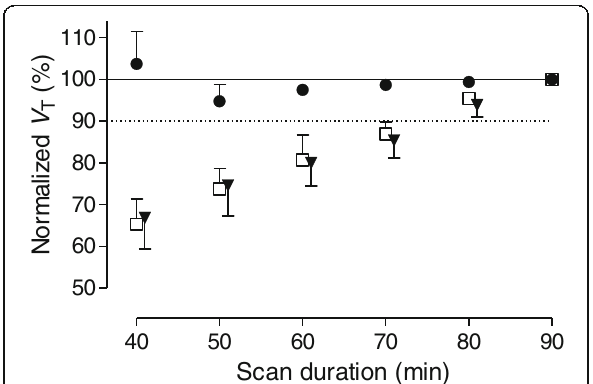
Fig. 1 Time-stability analysis. Total distribution volume ( V T ) of 11 C-( R) -PK11195 ( □ ), DPA-713 ( ▼ ), and ER176 ( ● ) obtained from low affinity binders (LABs) plotted as a function of duration of image acquisition. V T from each scan duration is normalized as percentage of V T over 90 min of